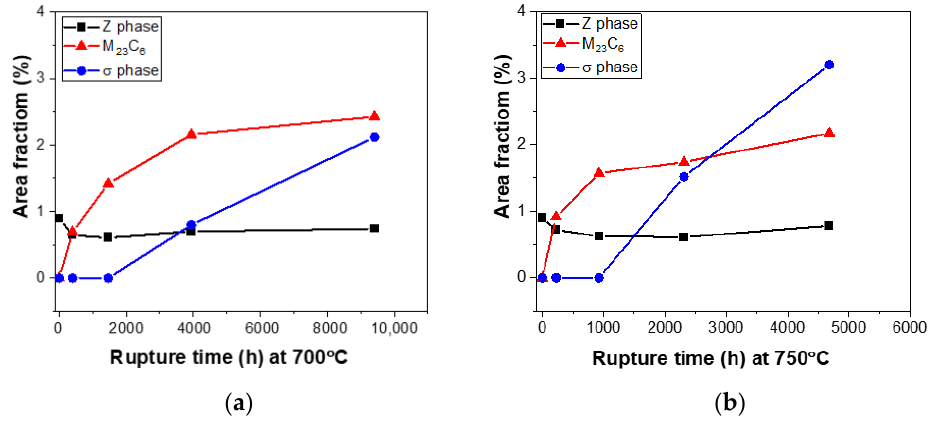
Figure 11. Precipitation evolution of Z-phase, M 23 C 6 , and σ phase at ( a ) 700 °C and ( b ) 750